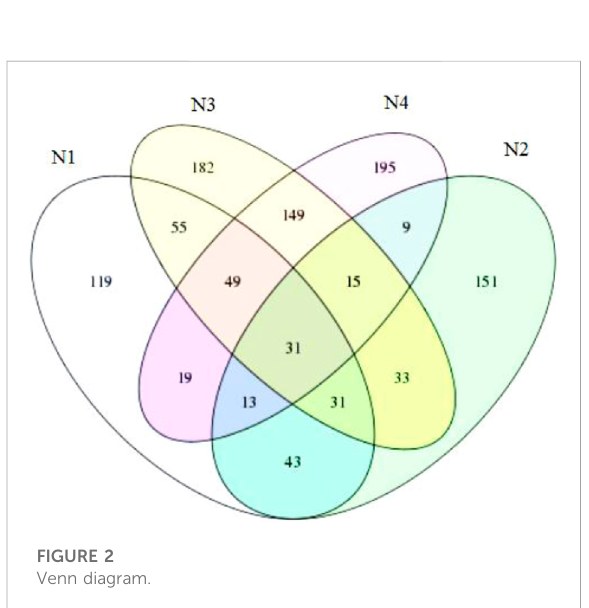
FIGURE 2 Venn diagram.